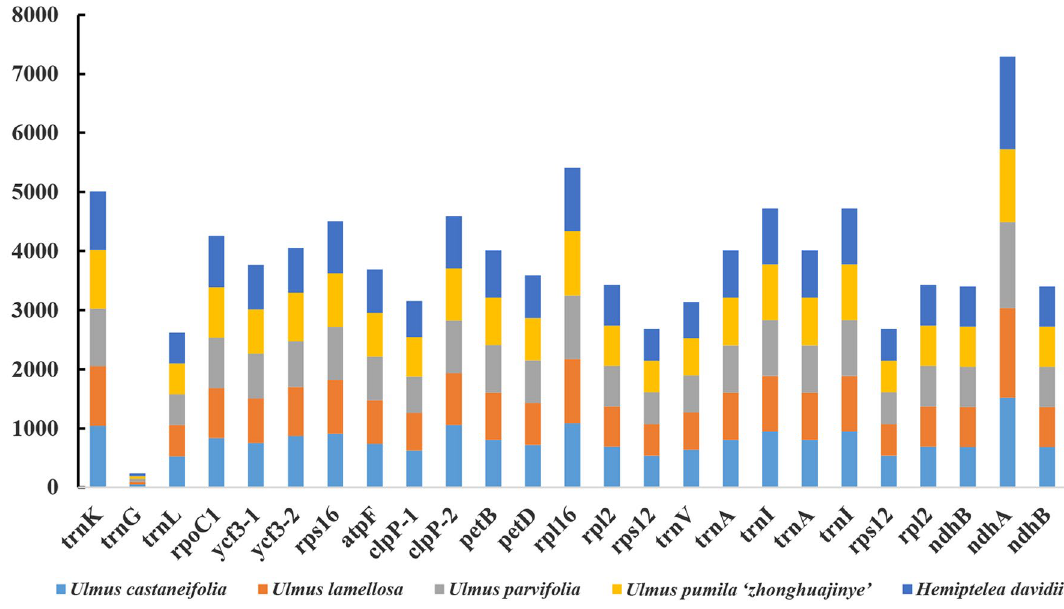
Figure 4. Intron length in the chloroplast genomes of four Ulmus species and H. davidii .